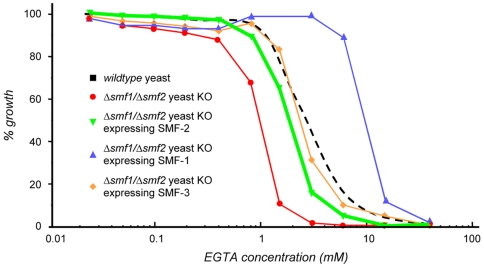

C. elegans SMF transporters rescue EGTA sensitivity of yeast ΔSmf1+ΔSmf-2 mutant.
S. cerevisiae double-mutant Smf1Δ+Smf-2Δ is hypersensitive to exposure to the divalent cation chelator EGTA (red), when compared to wildtype (dotted black line). Transvections of C. elegans smf-1 (blue), smf-2 (green) or smf-3 (orange) cDNA rescue the double-mutant hypersensitivity to EGTA.